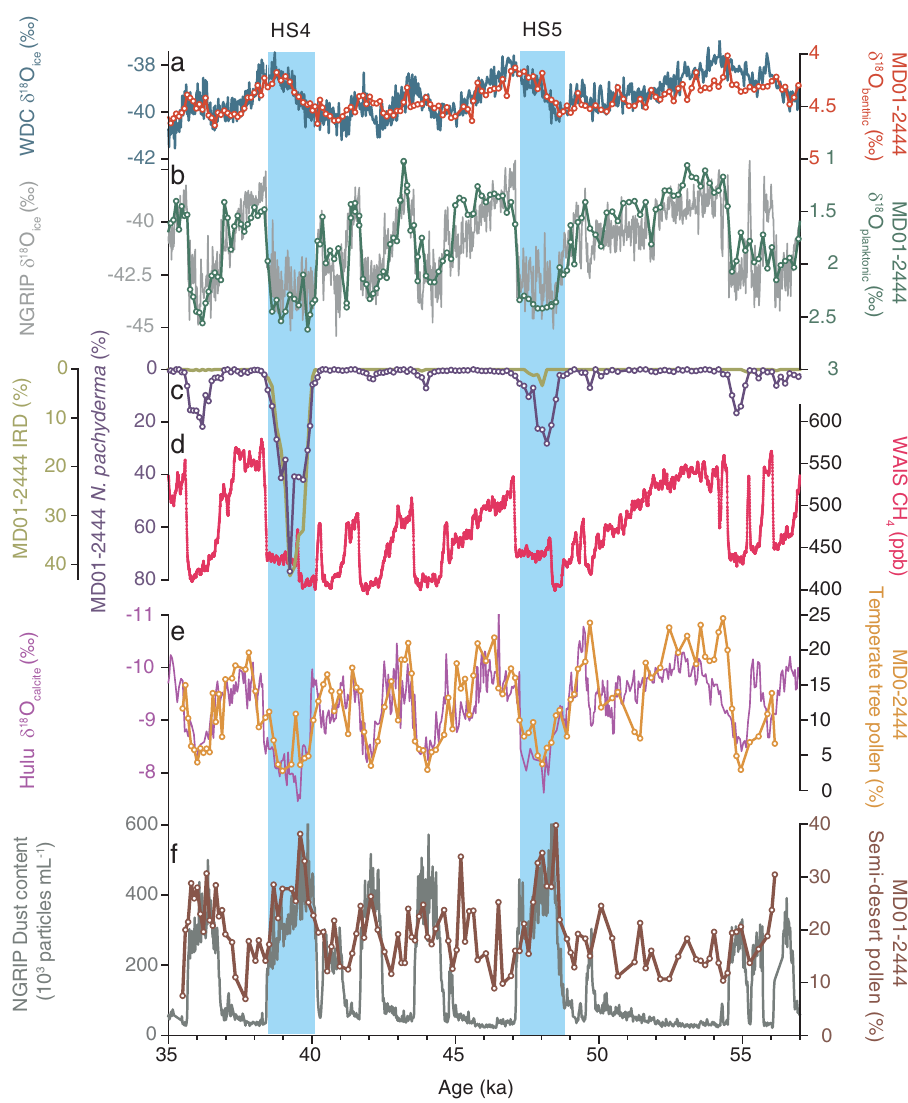
Fig. 4 Comparison of MIS 3 paleoclimate records. a West Antarctic Ice Sheet Divide ice-core (WDC) δ 18 O ice (ref. 42 ) and MD01-2444 δ 18 O benthic . b NGRIP ice-core δ 18 O ice (ref. 40 ) and MD01-2444 δ 18 O planktonic . c MD01-2444 percent IRD and N. pachyderma (inverse Y-scales). d Atmospheric methane concentration in WDC (ref. 17 ). e Hulu speleothem δ 18 O calcite (ref. 44 ) and MD01-2444 temperate tree pollen percentages. f NGRIP dust content 45 and MD01-2444 semi-desert ( Artemisia and Chenopodiaceae/Amaranthaceae) pollen percentages. All records are plotted on WD2014 timescale 41 , except Hulu, which is on its own U/Th chronology 44 . Vertical bars denote HS4 and